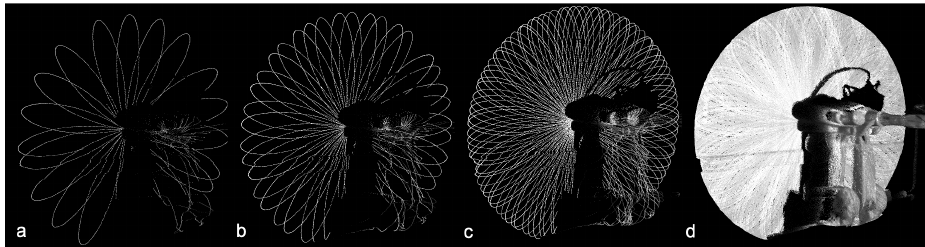
Figure 4. Points from Livox Mid-40 reading: ( a ) 100 ms, ( b ) 200 ms, ( c ) 1000 ms, ( d ) 5000